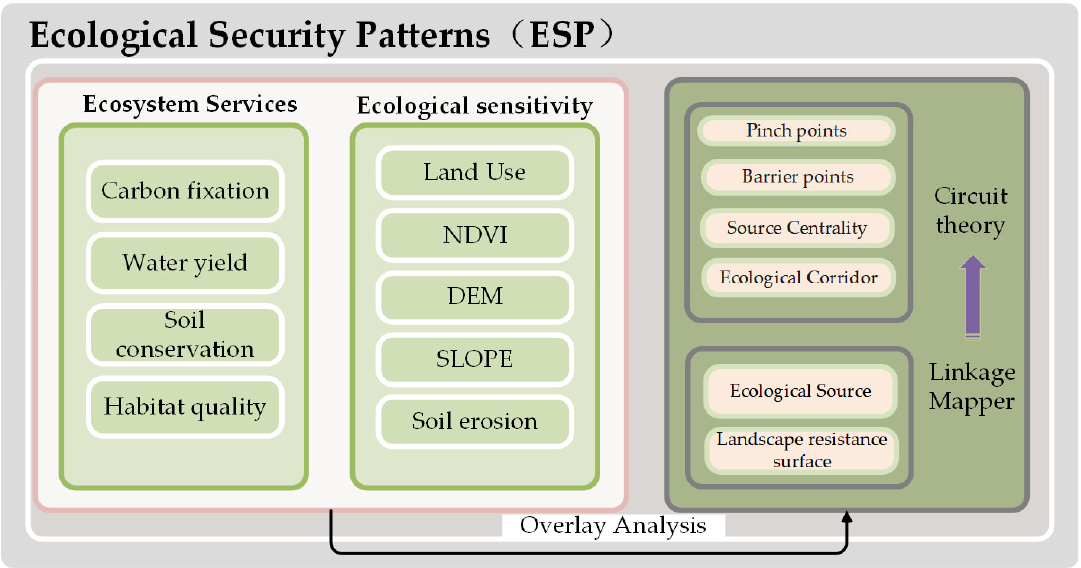
Figure 2. Framework for constructing the ecological security pattern in southern Anhui.